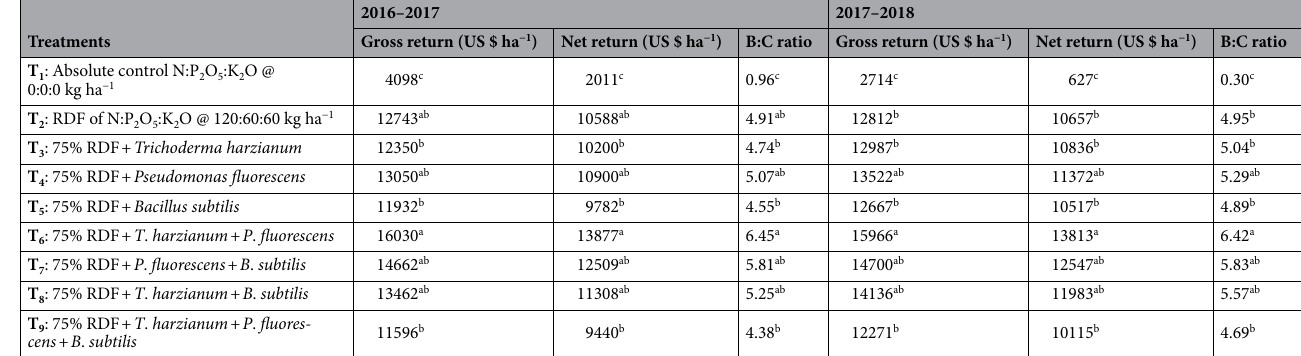
Table 5. Economics of red cabbage production as influenced by bio-priming and mineral fertilization. 1 US $ = 66 INR; Produce cost calculated @ 0.76 US $ kg −1 ; Spencer (Supermarket) cost = 2.42 US $ kg −1 . Different letters indicate significant differences at P ≤ 0.05 among the treatments as per